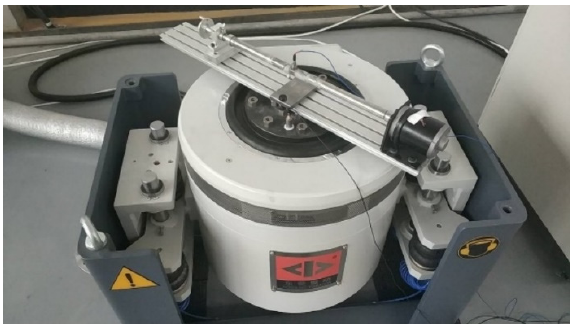
Figure 9. Vibration experiment layout.